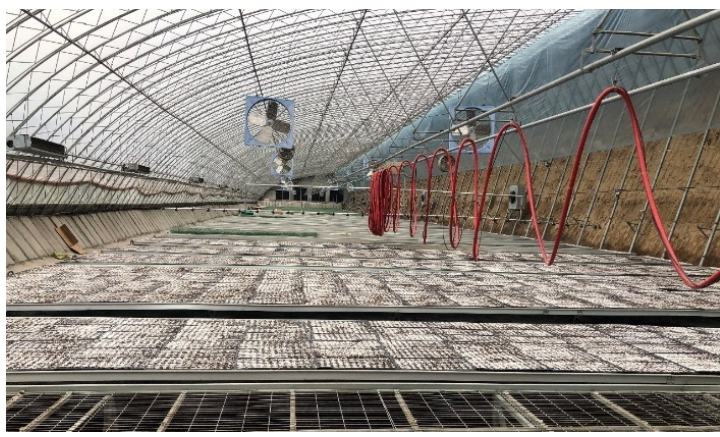
Figure 1. Greenhouse environment.